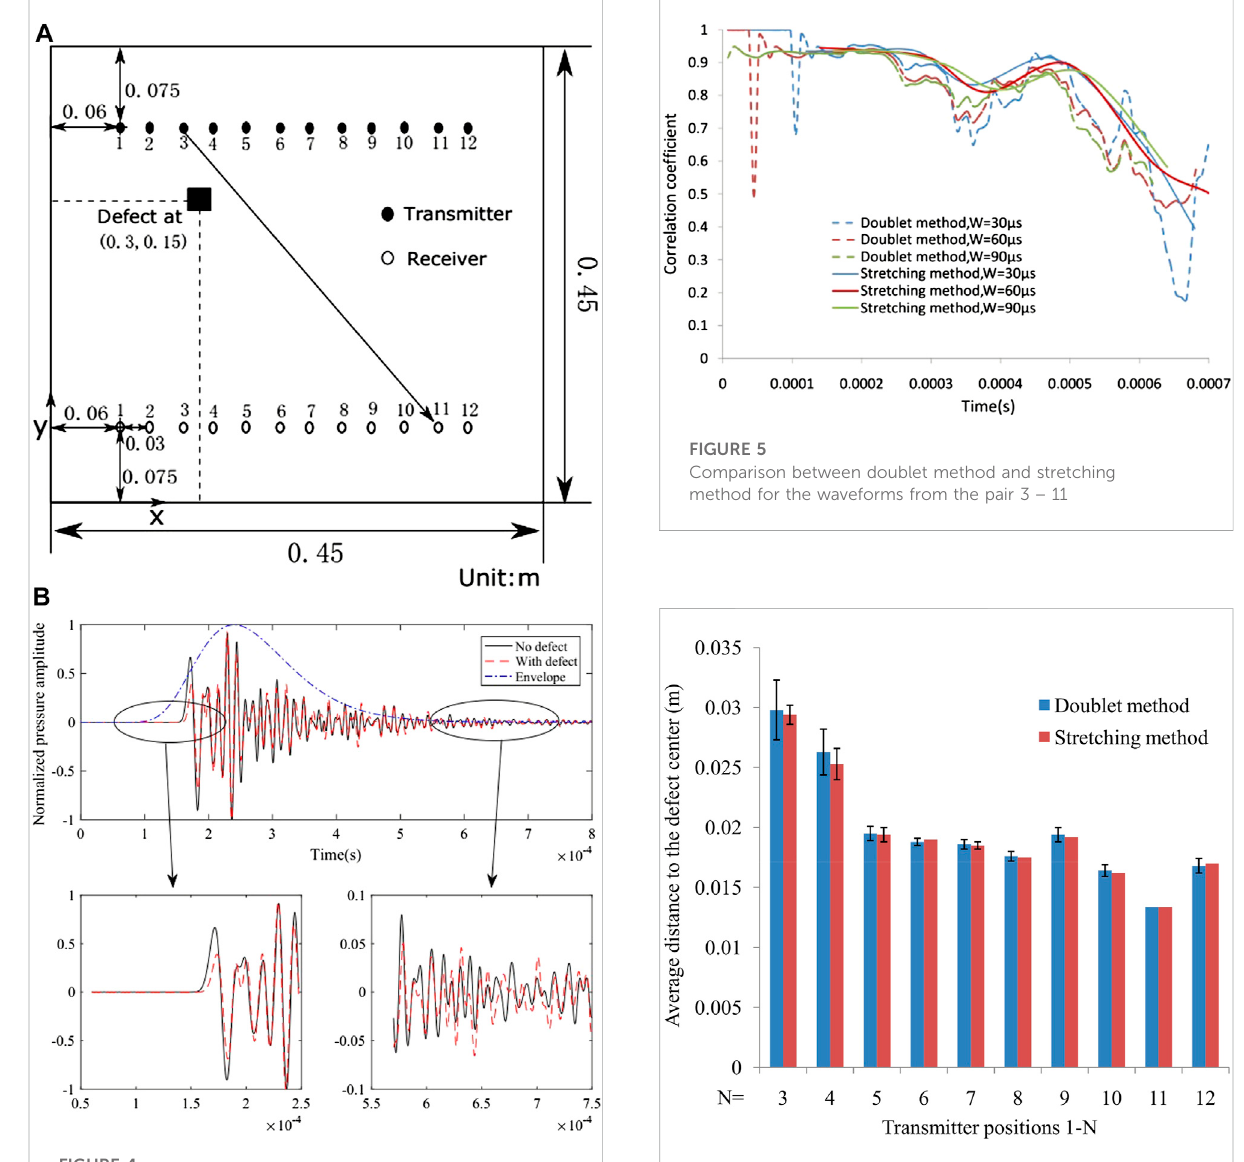
FIGURE 6 The average distances using different transmitters. Error bars represent the standard deviation